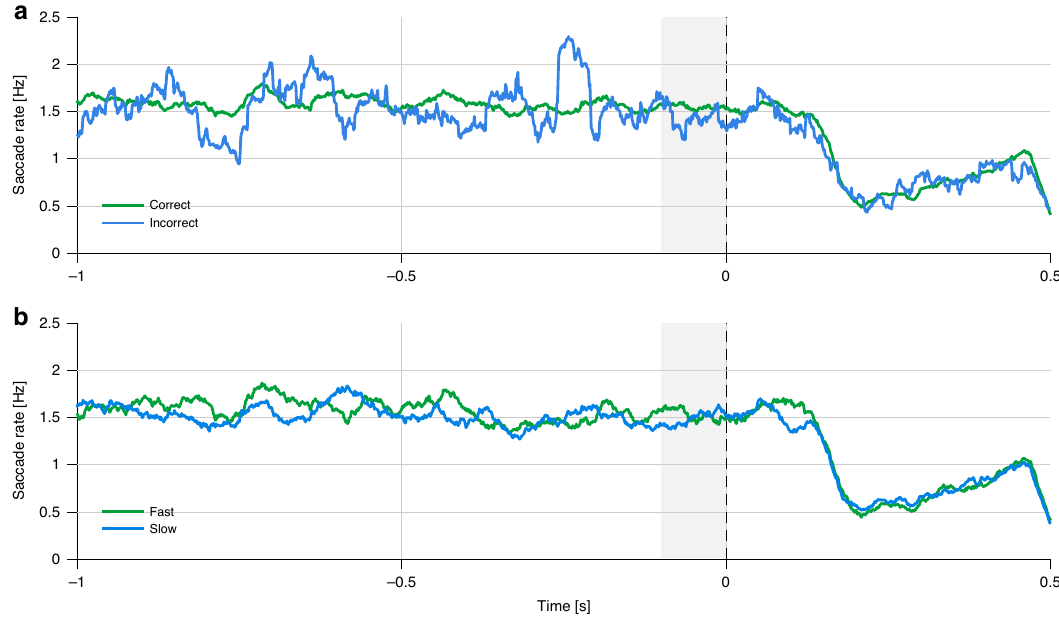
Fig. 6 Saccade rates according to trial performance. a Grand average saccade rates in correct trials (green) and incorrect trials (blue) of the unpredictable condition. The dashed line represents target onset. The gray rectangle marks the pre-stimulus analysis window. b Grand average saccade rates in fast trials (green) and slow trials (blue) of the unpredictable condition, divided according to the median. Source data are provided as a Source Data fi le.